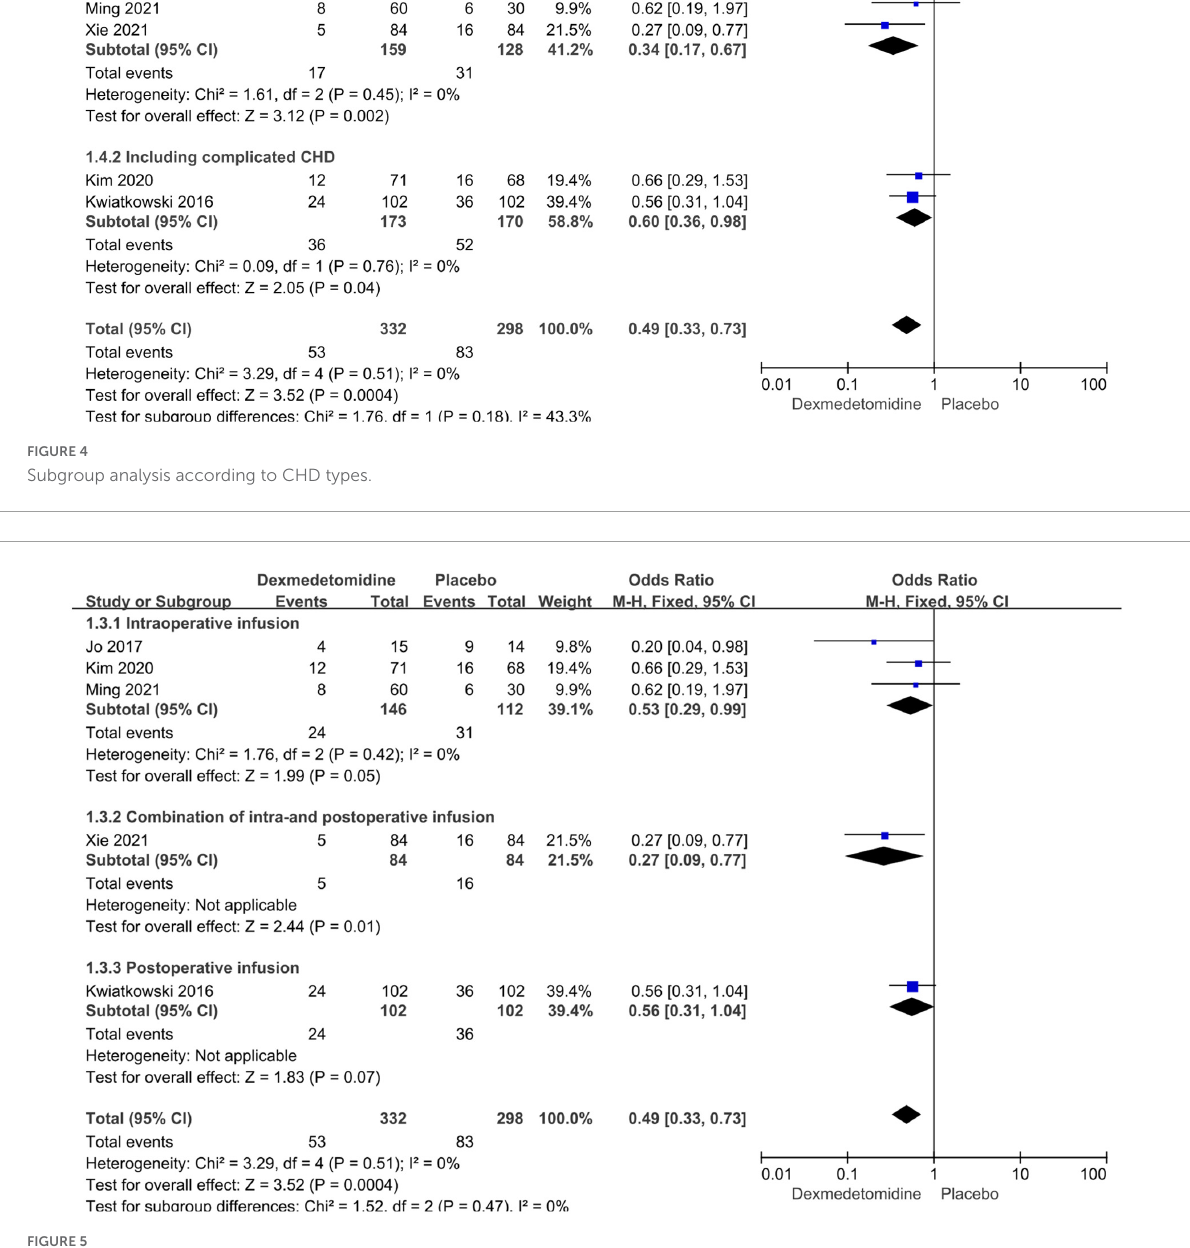
FIGURE5 Subgroup analysis according to intervention time (intraoperative, combination of intra- and postoperative, postoperative dexmedetomidine